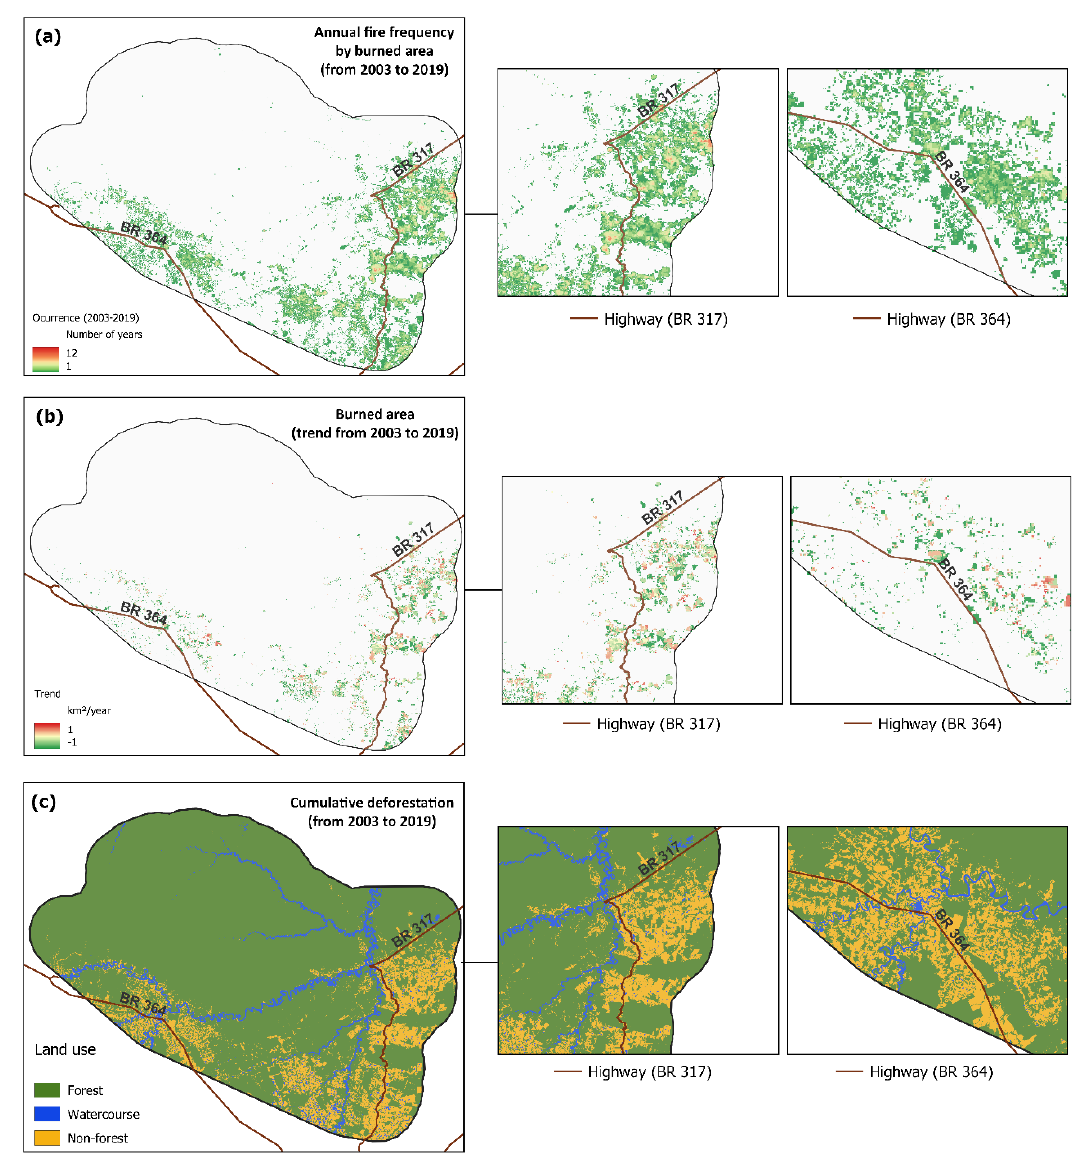
Figure 5. ( a ) Fire recurrence analysis (years) in the study region for the period from 2003 to 2019, and ( b ) spatial trends for each burned area (30 m spatial resolution) between 2003 and 2019; negative values (in green) represent a decreasing trend, while positive values (in red) represent an increasing trend and ( c ) land-use from 2003 to 2019 with cumulative deforestation.